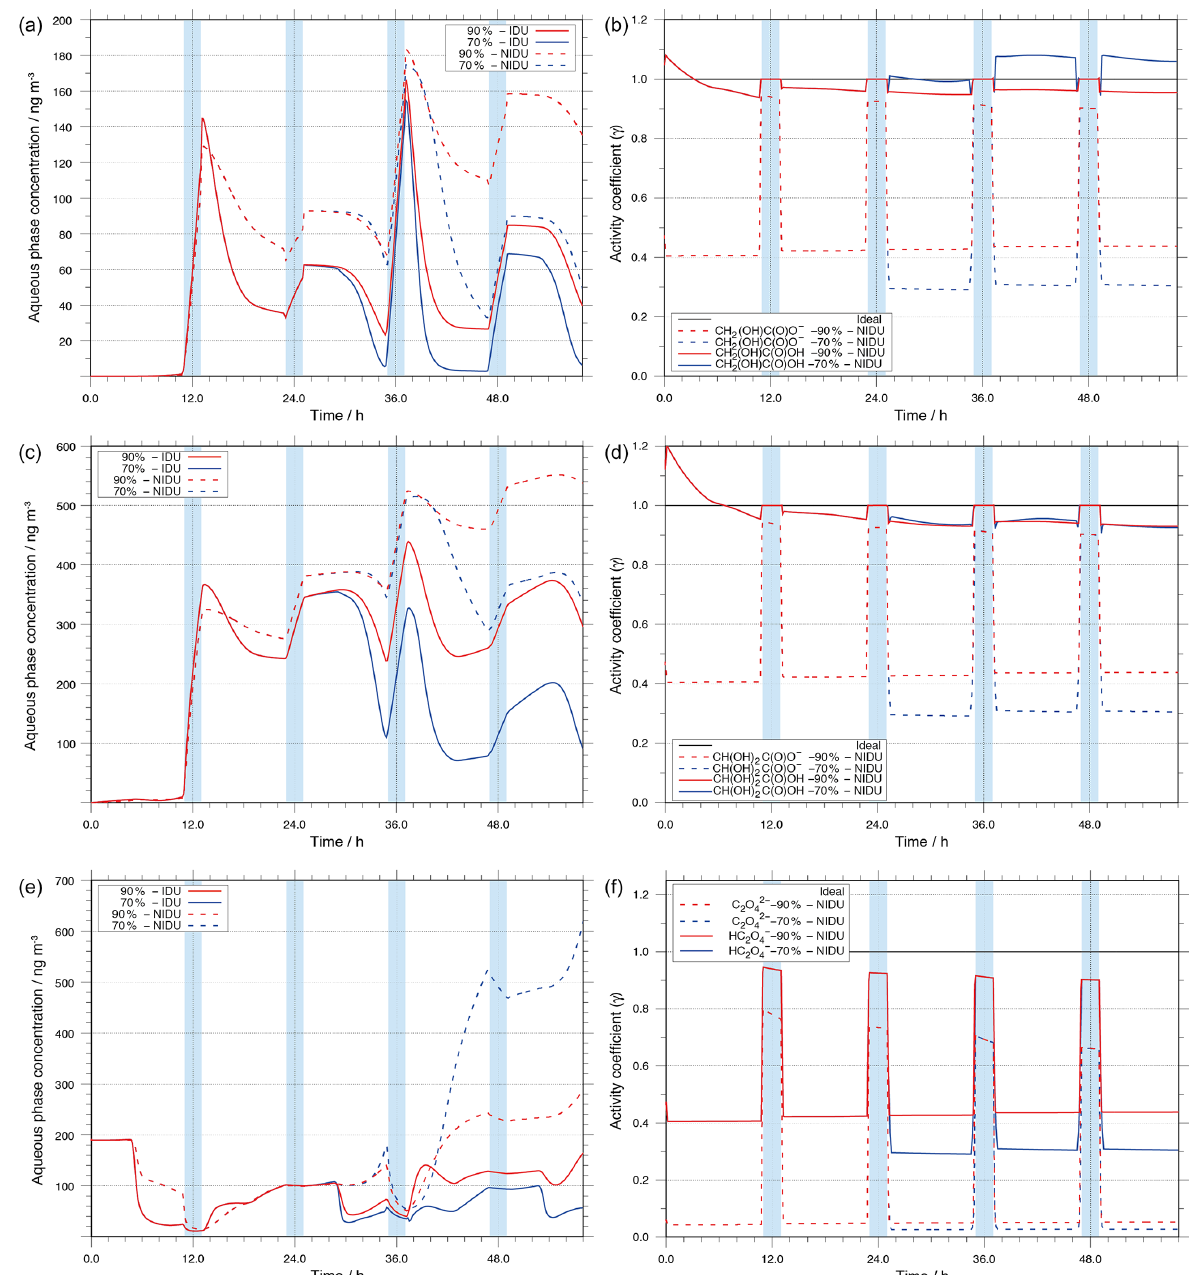
Figure 9. Modelled aqueous-phase concentrations in ngm − 3 and corresponding activity coefficients for the important C 2 oxidation prod- ( air ) ucts, (i) glycolic acid (a, b) , (ii) glyoxylic acid (c, d) , and (iii) oxalic acid (e, f) . The plotted concentrations represent the sum of the dissociated and undissociated forms of the